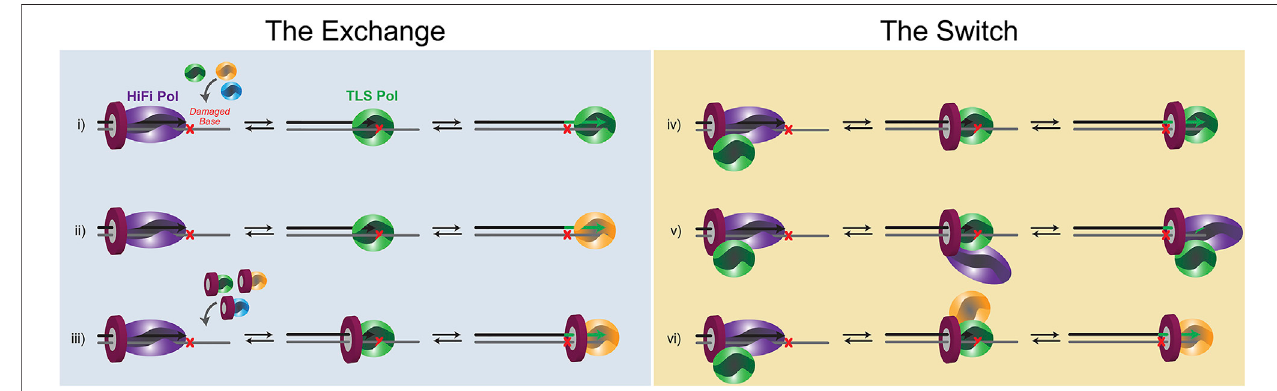
FIGURE 3 | Schematic of the potential equilibrium exchanges and PCNA-directed switches that occur for TLS. (i) a distributive Pol exchange before two- substitution TLS. (ii) A distributive Pol exchange before three-substitution TLSs. (iii) a distributive PCNA/Pol exchange before two (or three)-substitution TLS. (iv) A concertedPol switch withapre-associatedTLSPol. (v) AconcertedPol switch withtheHiFiPolremainingboundtoPCNAthroughoutTLS. (vi) ConcertedPol switches during three-substitution TLS.